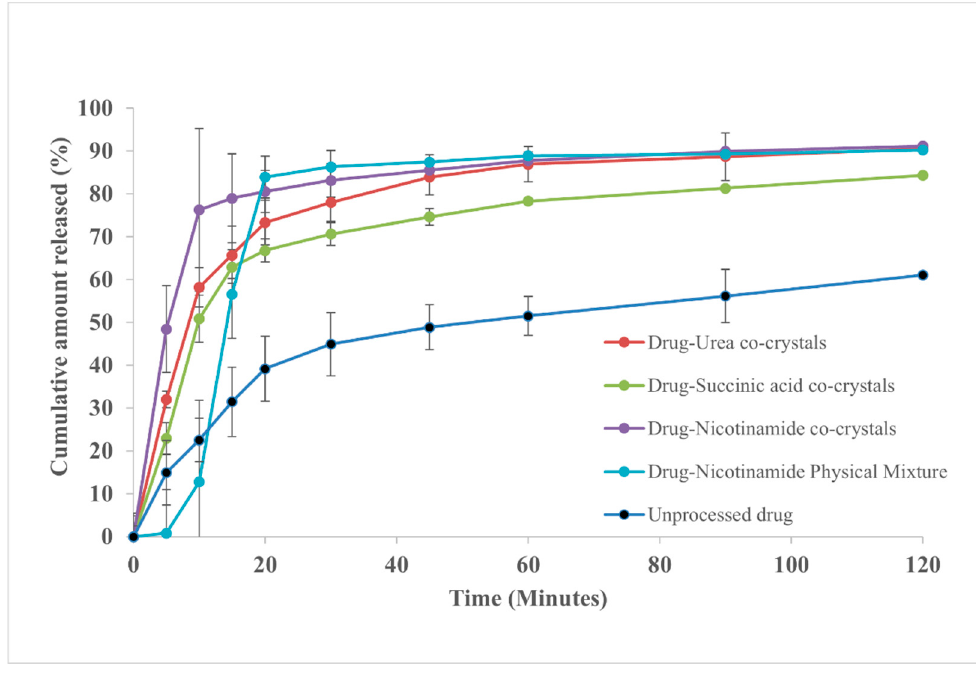
Figure 4. The in vitro dissolution of asenapine maleate from drug–urea co-crystals, drug–succinic acid co-crystals, drug–nicotinamide co-crystals and drug–nicotinamide physical mixture in ratio 1:3 in 900 mL phosphate buffer pH 6.8 at 37 ± 0.5 °C and 75 rpm.